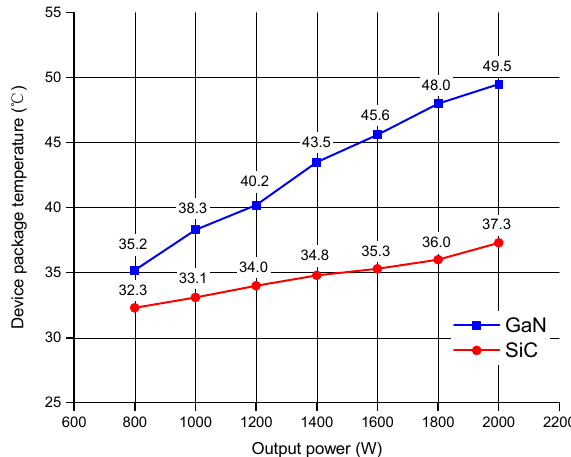
Figure 12. Device package temperature measurement results according to the output power.